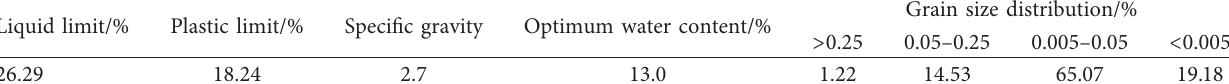
Table 1: Index properties and grain size distribution of the tested